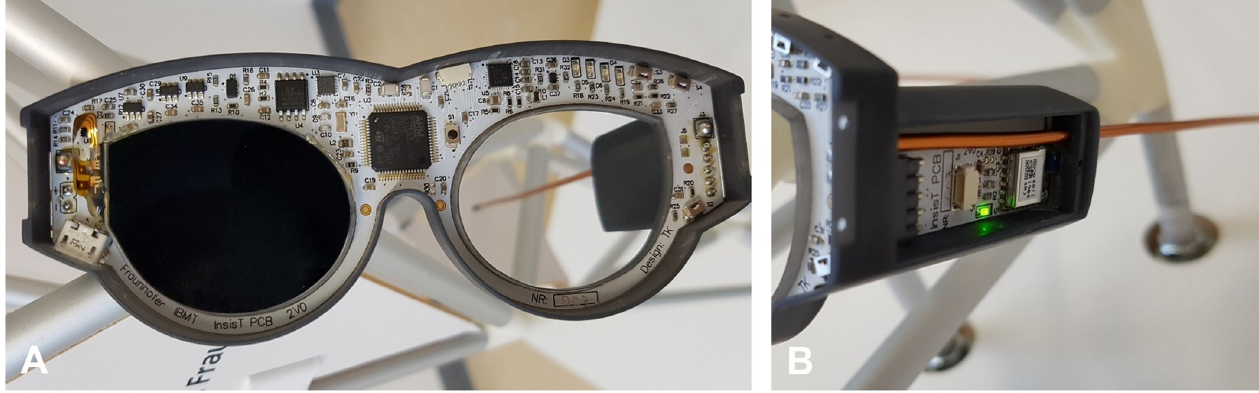
Fig 4. Photographs of electronic glasses frame. (A) Assembled LCD shutter glasses for children without frame cover and with one activated LCD lens. (B) Side view of the left temple with integrated Bluetooth module; the battery is located on the opposite side.